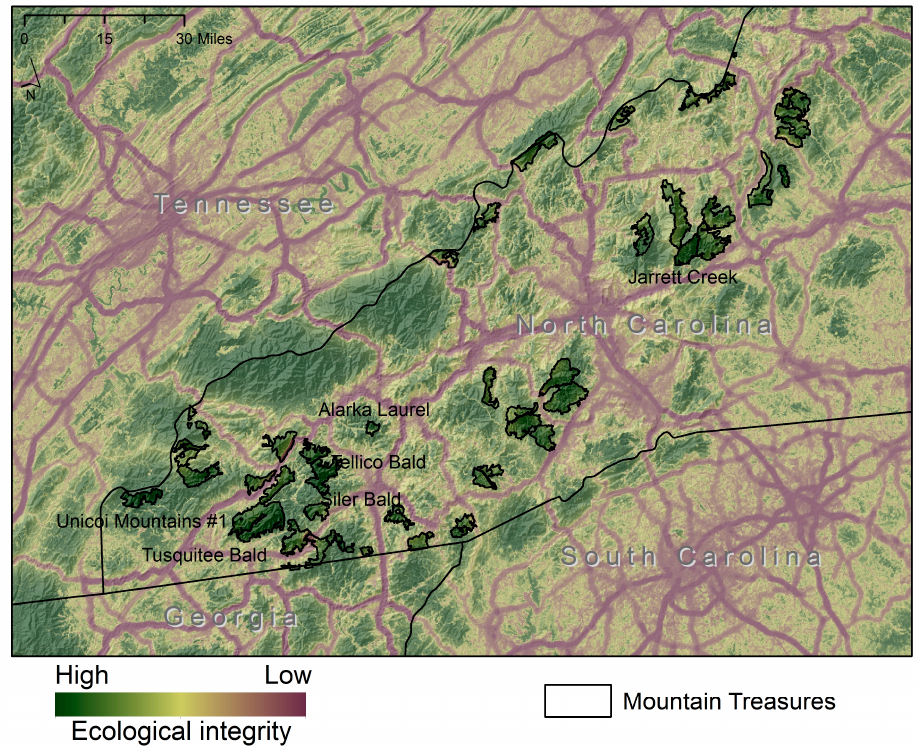
Figure 3. Map of ecological integrity for the Southern Appalachian Mountains highlighting the Mountain Treasures. While the Mountain Treasures have on average lower ecological integrity scores compared to all other roadless areas, it is important to note their regional significance for sustaining relatively intact and wild, some of the wildest places in the Southeastern U.S. Table 1. Summary statistics for each index used to compare North Carolina’s Mountain Treasures with other US Forest Service (USFS) candidates for additional protection. All indices are based on data compiled by Belote et al. (2017) and range from 0 to 1, except for the composite wildland conservation value which had a maximum possible value of